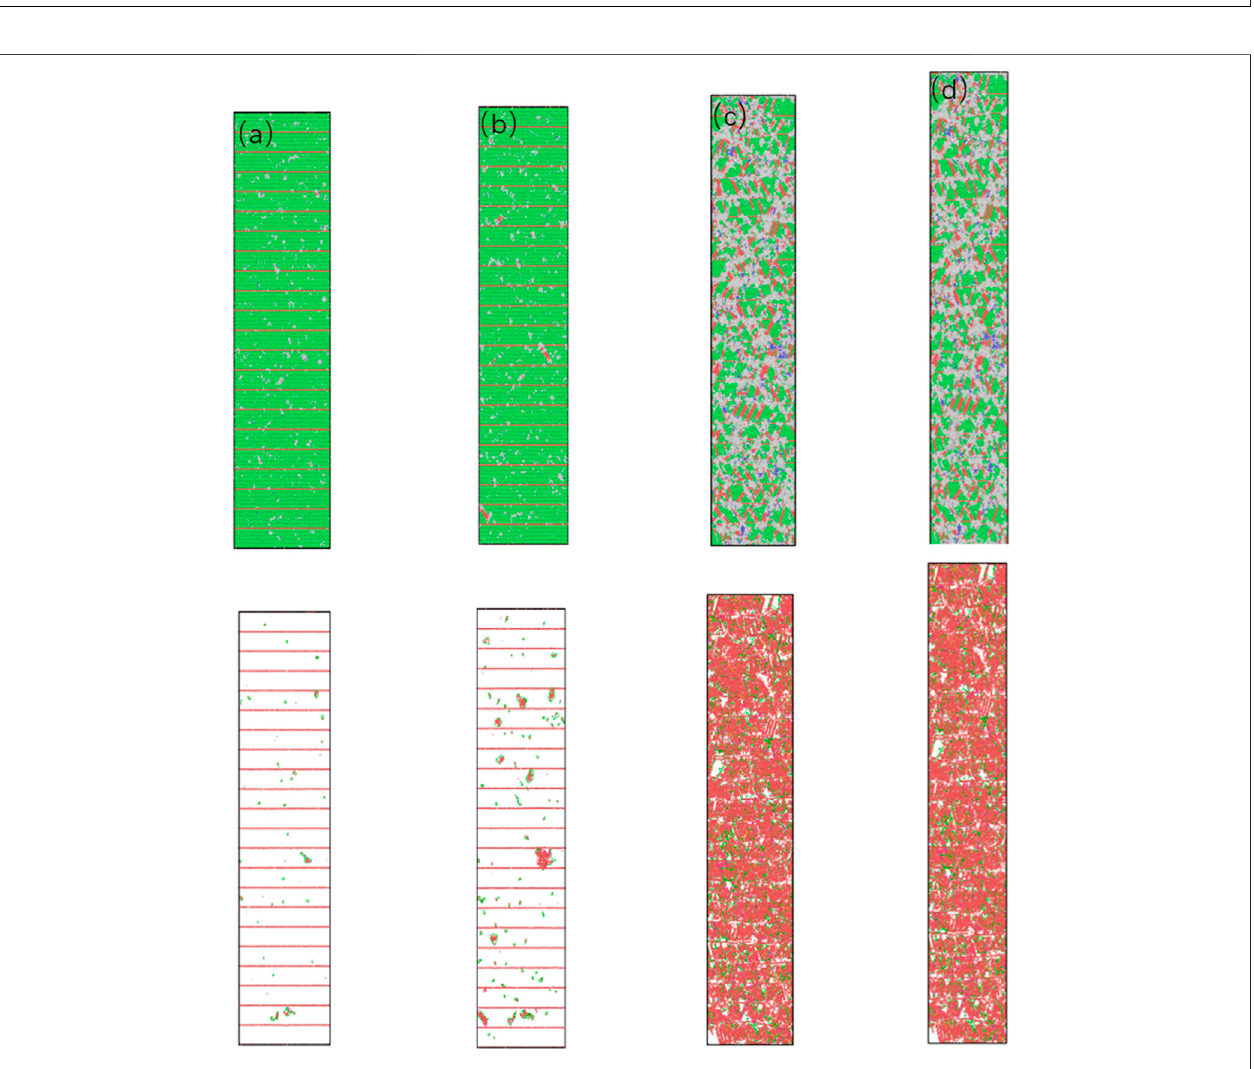
Frontiers in Materials |